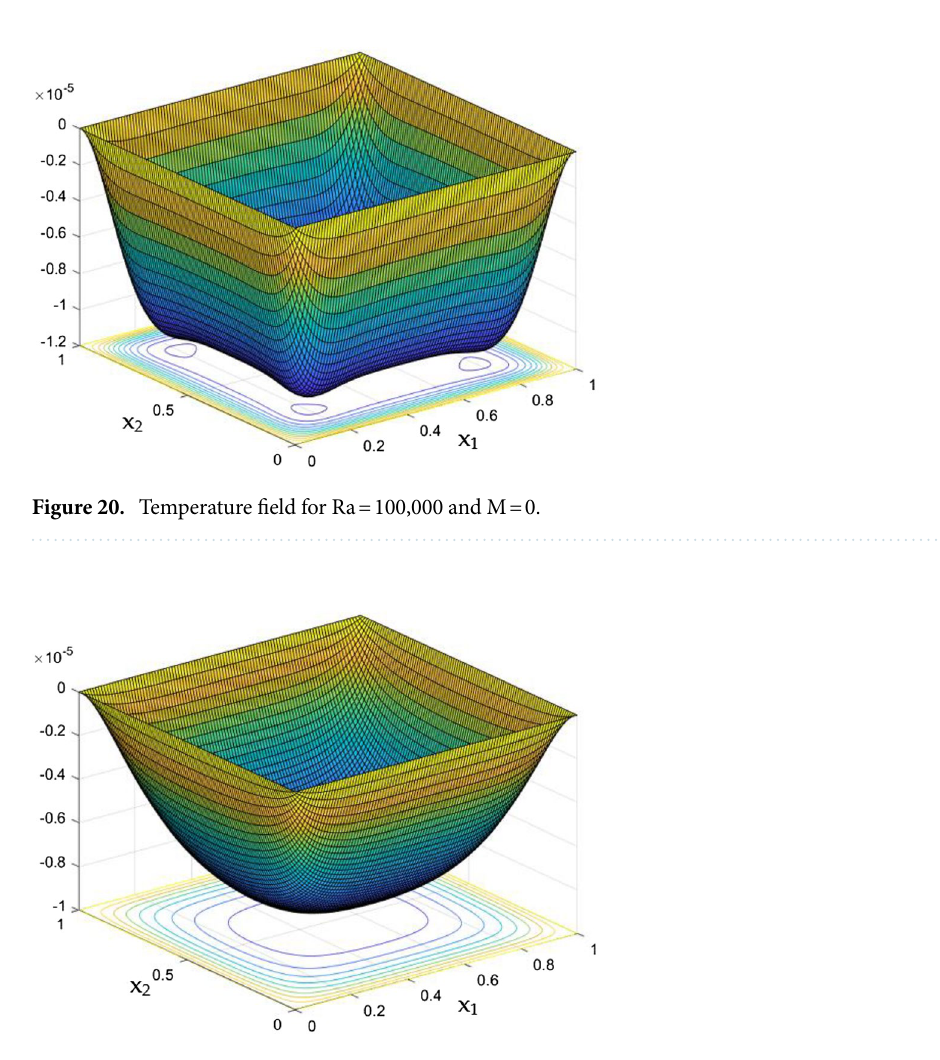
Figure 21. Temperature field for Ra = 100,000 and M =